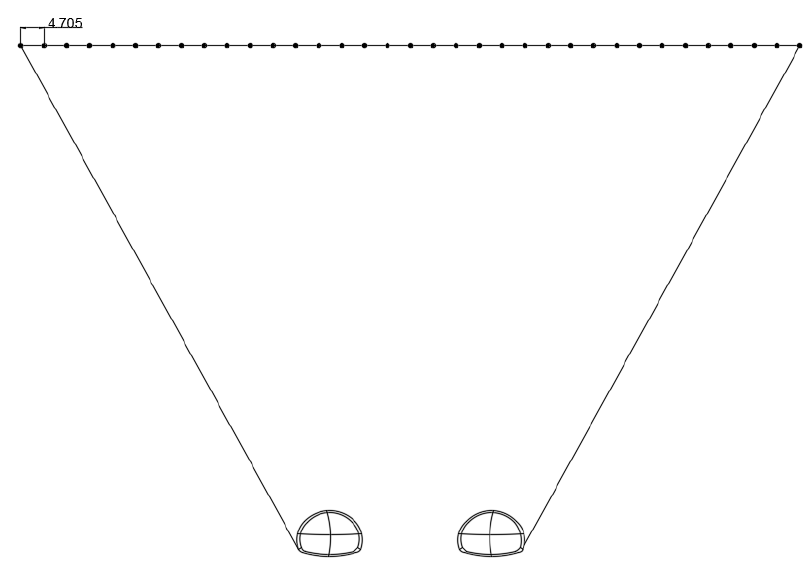
Figure 13. Schematic diagram of lateral arrangement of the surveying sections.